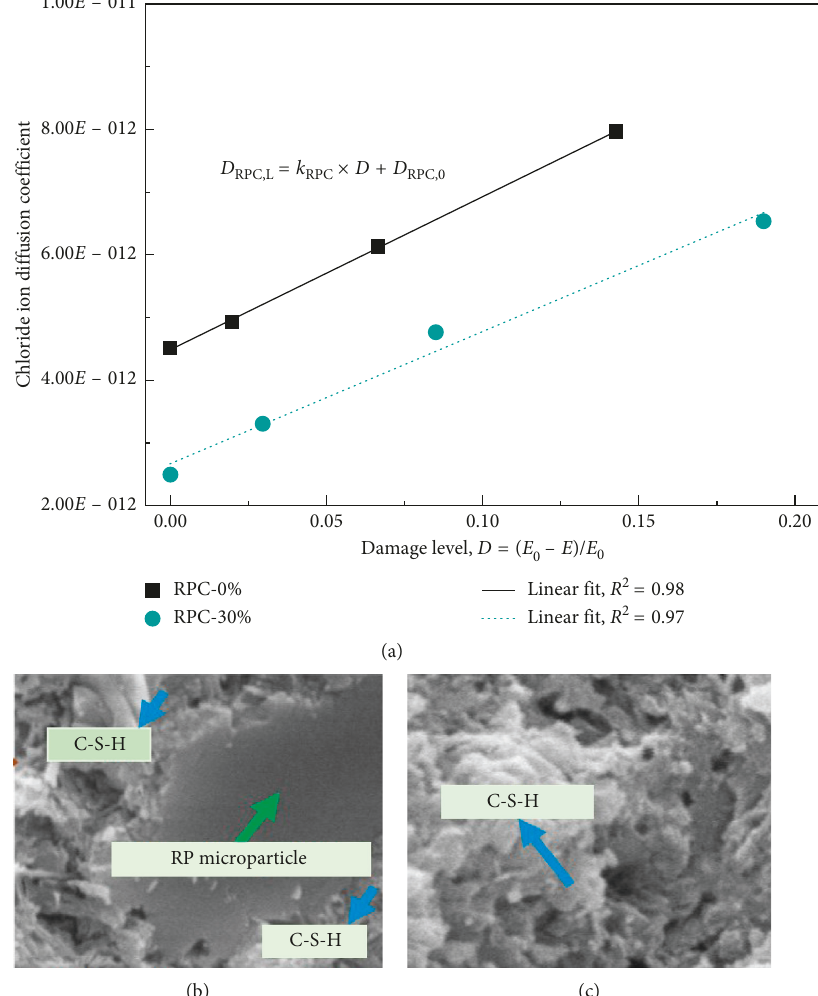
Figure 12: Relationship between the chloride diffusivity of RPC and the loading damage. (a) Chloride diffusivity of RPC with various damage levels. (b) SEM images for the neat paste of RPC and natural